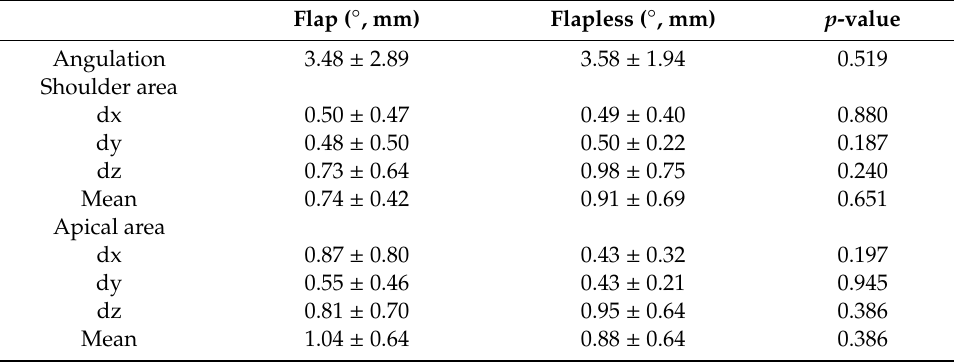
Table 8. Flap or flapless surgery (mean ±